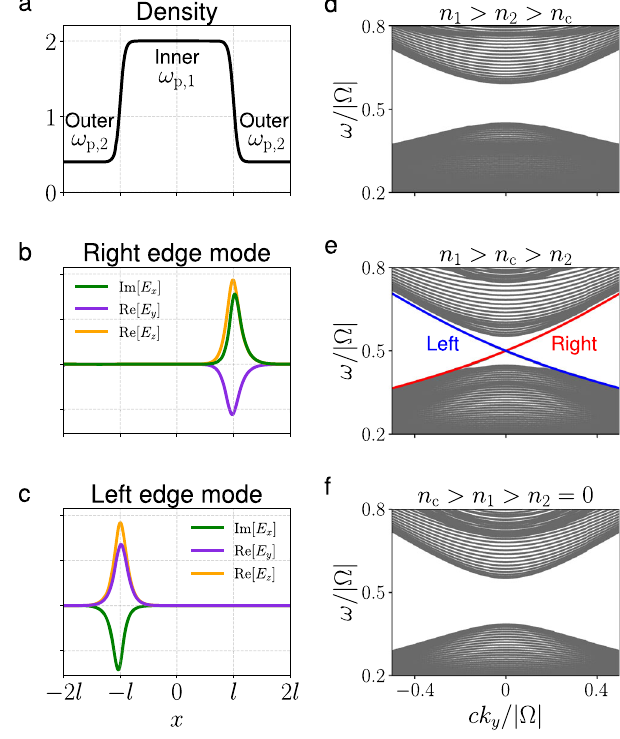
Fig. 4 The band structures of nonuniform plasmas at ck z / ∣ Ω ∣ = 0.7. a Schematic diagram of the density pro fi le in x direction, where cl / ∣ Ω ∣ = 40 and c δ / ∣ Ω ∣ = 4. b , c The non-zero components of electric fi elds of edge modes in ( e ) at ck y / ∣ Ω ∣ = 0.05. d – f The band structure ω ( k y ) with various inner and outer densities. The plasma frequencies ( ω p,1 , ω p,2 )/ ∣ Ω ∣ are (0.8, 0.6), (0.6, 0.4), and (0.4, 0) in ( d ) – ( f ), respectively. The topological edge modes on left and right side are shown by blue and red lines, respectively. The rest modes are shown by gray lines. Notice that the critical plasma frequency given by Eq. (5) is ω p,c / ∣ Ω ∣ ≈